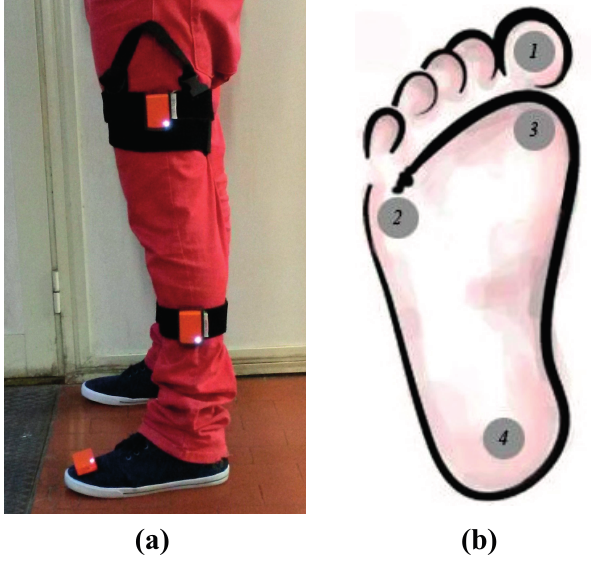
Figure 3. ( a ) Position of IMUs on participants’ left lower limb; ( b ) position of foot switches (1: toe, 2: fifth metatarsophalangeal, 3: first metatarsophalangeal, and 4: